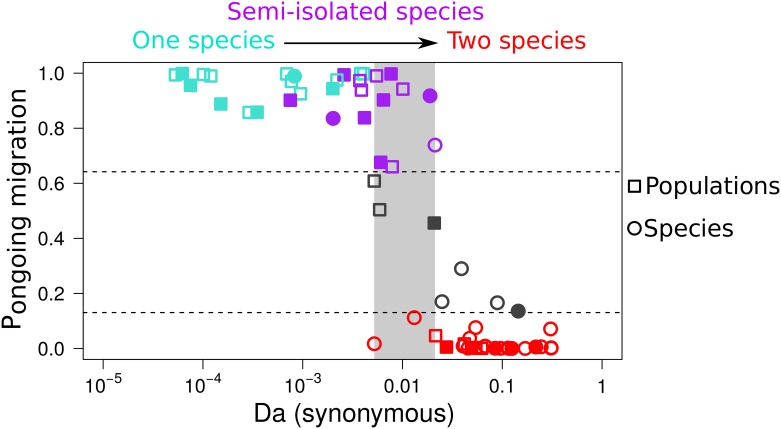
Probability of ongoing gene flow along a continuum of molecular divergence.Each dot is for one observed pair of populations/species. x-axis: net molecular divergence Da measured at synonymous positions (log10 scale) and averaged across sequenced loci. y-axis: relative posterior probability of ongoing gene flow (i.e., SC, IM, and PAN models) estimated by ABC. Red dots: pairs with a strong support for current isolation. Grey dots: pairs with no strong statistical support for any demographic model (robustness <0.95). Blue dots: pairs with strong statistical support for genome-homogeneous ongoing gene flow. Purple dots: pairs with strong statistical support for genome-heterogeneous ongoing gene flow. Filled symbols: pairs with a strong support for genome-heterogeneous Ne. Open symbols: genome-homogeneous Ne. The light grey rectangle spans the range of net synonymous divergence in which both currently isolated and currently connected pairs are found (see S1 Data).